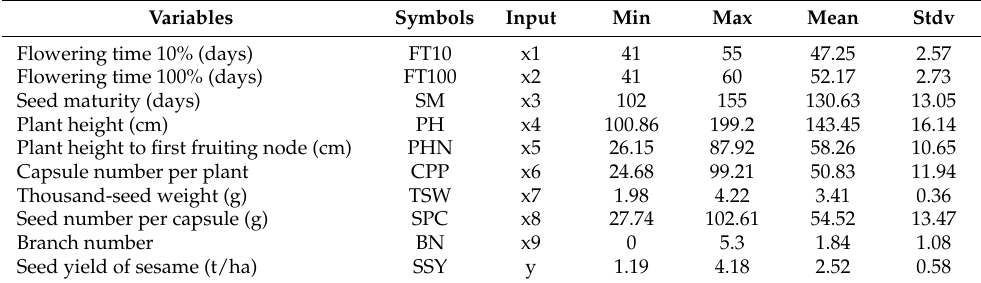
Table 2. Summary of the measured statistical parameters for the agronomic trait data. Variables Symbols Input Min Max Mean